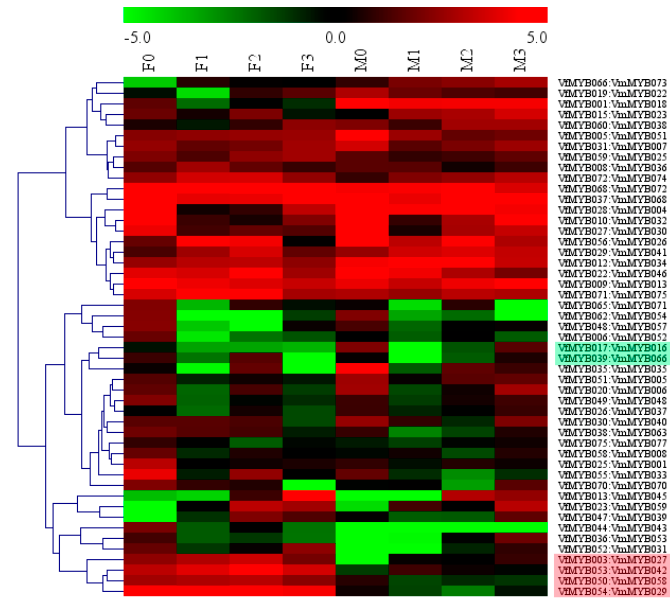
Figure 4. Expression profiles of Vf/VmMYB homologous genes under infection by Fof-1 in V. fordii and V. montana. F0-F3 represented the expression of VfMYB homologous genes in V. fordii during the infection stage (0, 1, 2, 3) by the pathogen Fof 1; M0-M3 represented the expression of VmMYB homologous genes in V. montana during the infection stage (0, 1, 2, 3) by the pathogen Fof 1. The expression levels were illustrated by the gradient color. Red and green represent high and low expression level respectively.